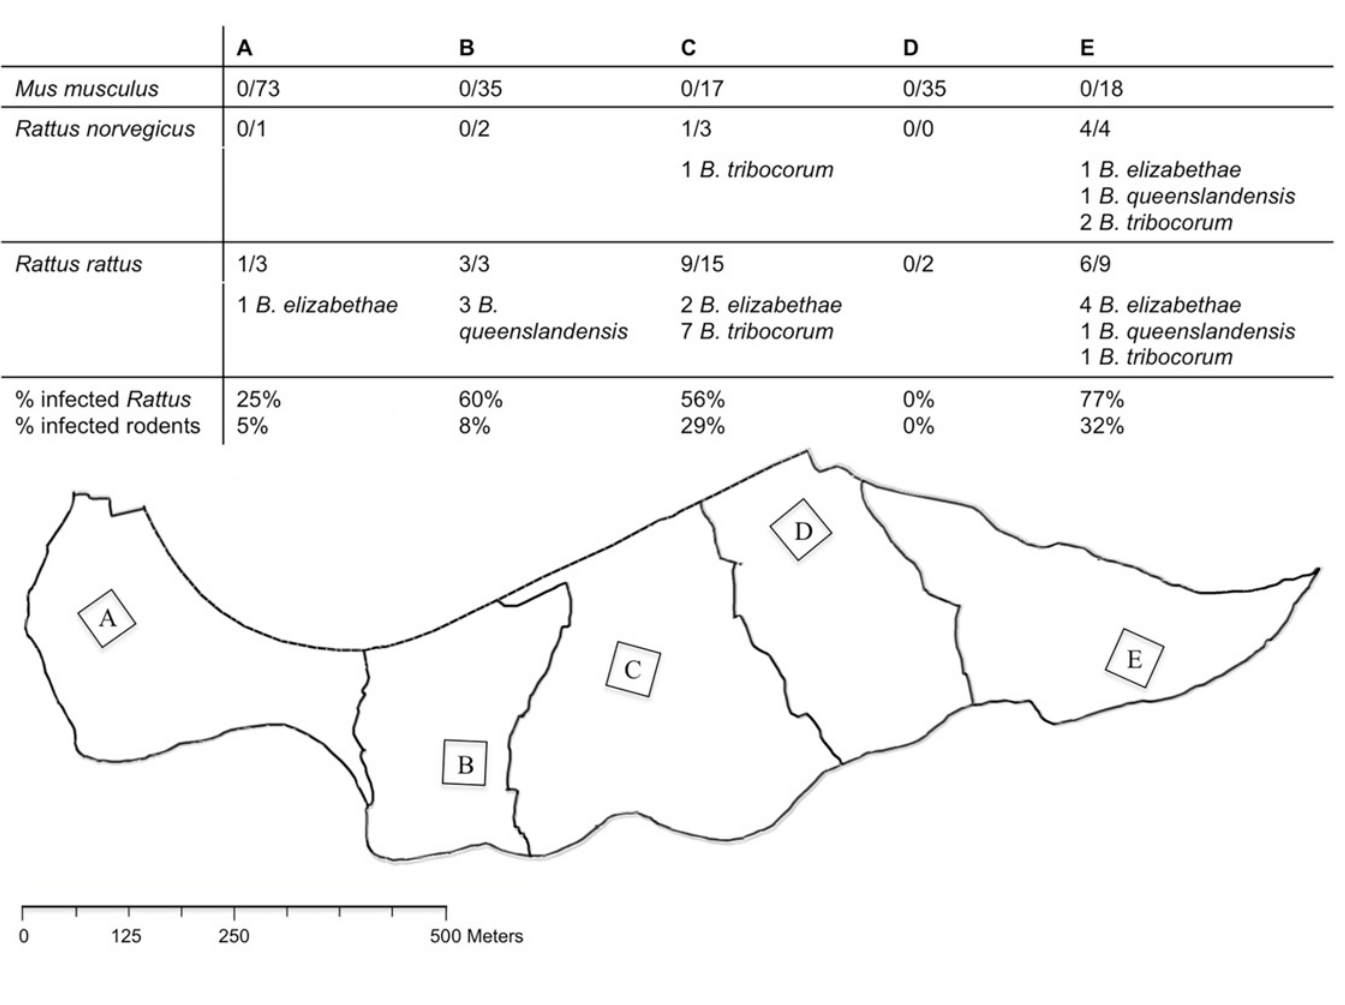
Fig 2. Map and summary of rodent trapping sites in Kibera. Summary of the rodents trapped and Bartonella isolates obtained within different trapping zones (A to E) at the Kibera study